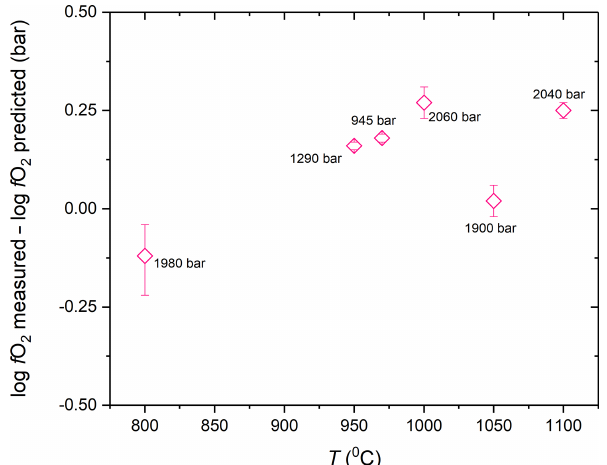
Figure 9. The success of our method to impose targeted f O 2 in the experiments. The difference between the measured f O 2 and the predicted f O 2 is plotted as a function of T to demonstrate the accu- racy of f O 2 prediction. The measured f O 2 is the value determined by the CoPd alloy redox sensor experiment corrected to zero time by using the hydrogen permeability constants of the MHC alloy de- termined in this study. The numbers in label show the run P of the experiment.